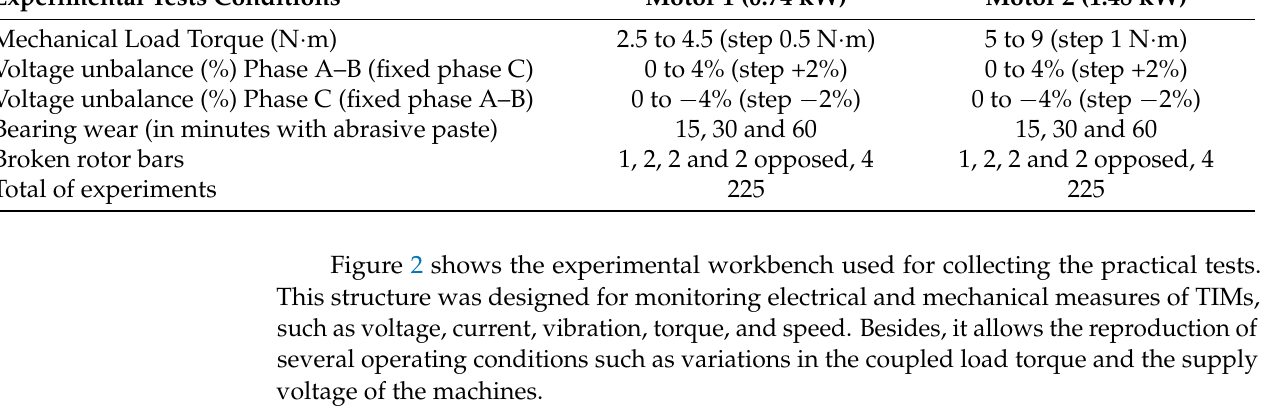
Table 1. Summary of motor operating conditions used to obtain the experimental data set Experimental Tests Conditions